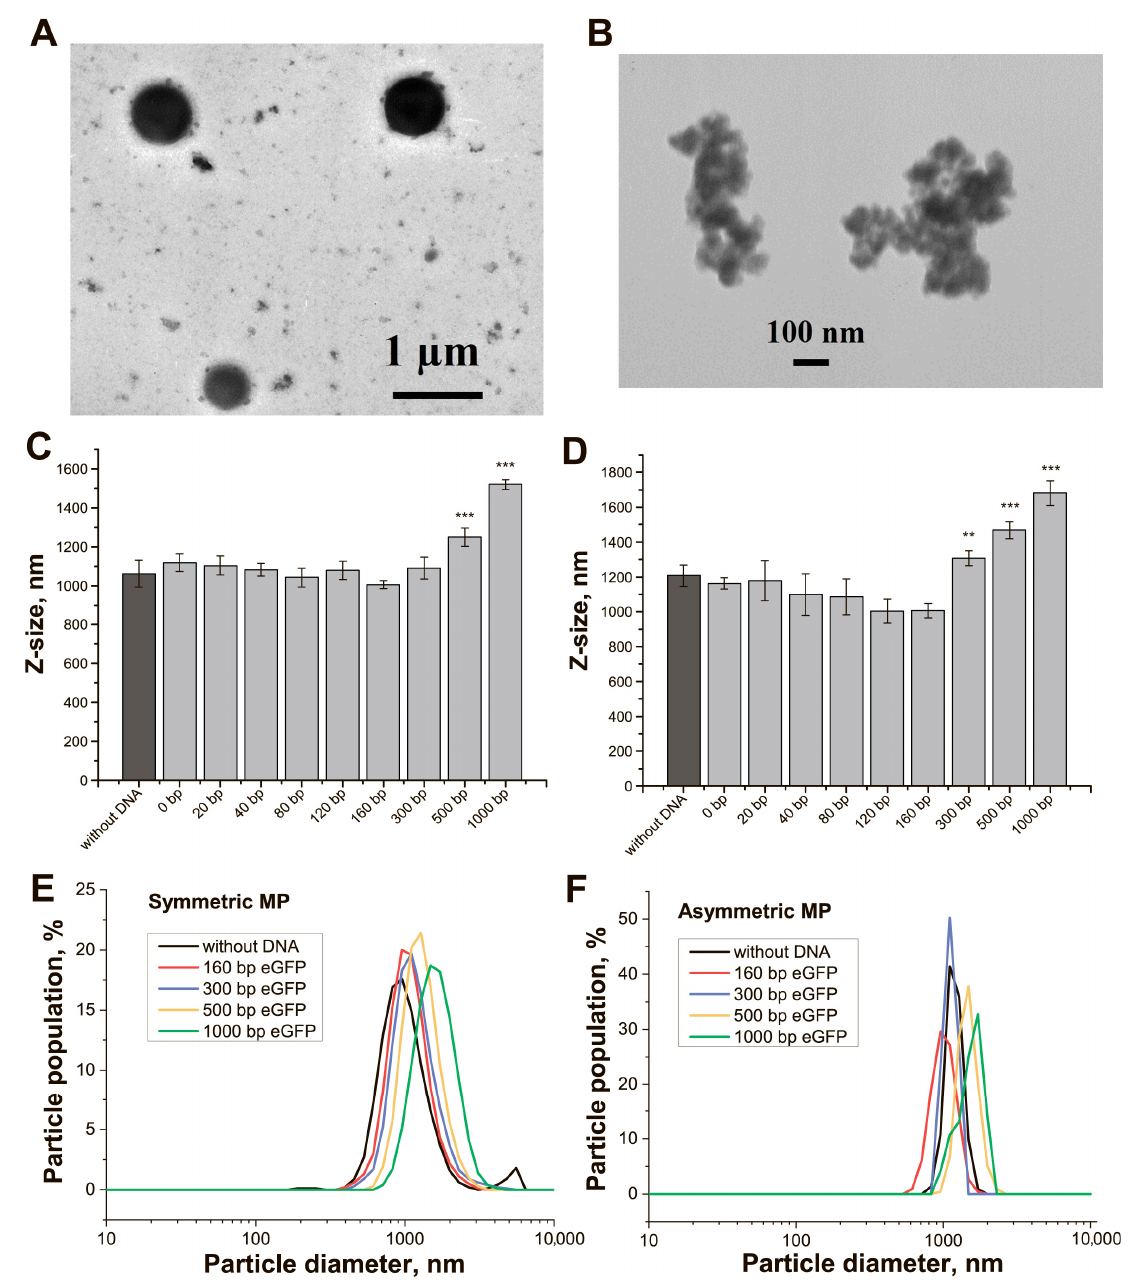
Figure 2. Characterization of streptavidin-MPs and their conjugates with biotinylated DNAs for trans-cleavage. TEM image of ( A ) SMPs, ( B ) AMPs. Dh values of ( C ) SMPs and their conjugates, ( D ) AMPs and their conjugates. Dh distribution for ( E ) SMPs and their conjugates, ( F ) AMPs and their conjugates. Difference from control (dark gray column): **- p -value < 0.05%, ***- p -value < 0.01%. For all trans-targets, we determined the percentage of bound DNA targets by MPs (loading). The loadings were in the range of 80% (eGFP-300)-96% (eGFP-0) regardless of the MP type (Table S7, Figure S8 (gray columns), Supporting Information). SMPs bound up to 54% of eGFP-500 or 34% of eGFP-1000 targets. AMPs bound to 51% of eGFP-500 or 33% of eGFP-1000 targets. Similar loadings were shown for IGS(I)-cis-targets (Table S8, Supporting Information). The effective concentration of DNA in the conjugates was esti- mated based on the loading that was used for further